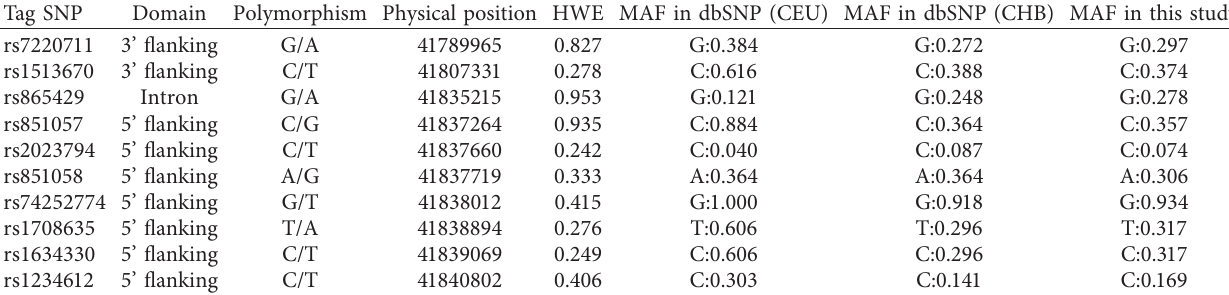
Table 3: Information of the analyzed SOST tag SNPs.